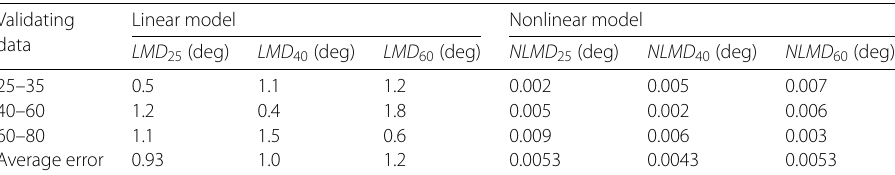
Table 3 Error comparison of the linear and nonlinear models with delay for the roll responses Validating data